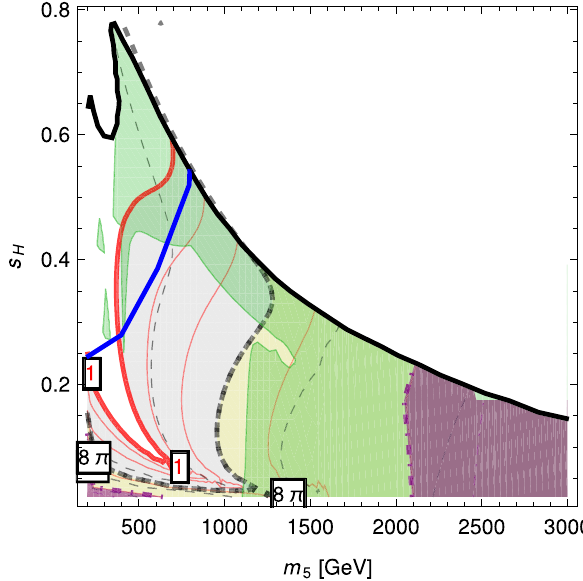
Fig. 10 Constraints on the parameter space in the m 5 - s H plane using the other parameters according to eq. (4.21). Points above the black (blue)thicklineareexcludedduetotheoreticaltree-levelbounds(direct LHC searches [60]) according to Ref. [61]. The grey shaded area with the red contour lines shows the OS perturbativity constraints based on the relative size of the counter-terms. The red contours correspond to Max ( | δλ x /λ x | ) = 1 , 2 , 4 , 16 and 64. The yellow shaded area corre- sponds to the unitarity constraints using renormalised parameters. The black dashed contours correspond to the associated scattering eigen- values of 4 π , 8 π , 16 π and 64 π . As the green contour we show the MS constraints from the size of the two-loop corrections vs. the one- loop corrections. Regions tainted green do not pass the constraint, i.e. ) − ( m 2 ) | / | ( m 2 ) − ( m 2 ) | ) > 1, i = 1 , 2 , 3. Max ( | ( m 2 φ 2L 1L Tree 1L φ i φ i φ i i Finally, the purple shaded area corresponds to the perturbativity con- straints on the absolute size of the CTs. The purple dot-dashed contours correspond to Max ( | δλ x | ) = 2 π and 4